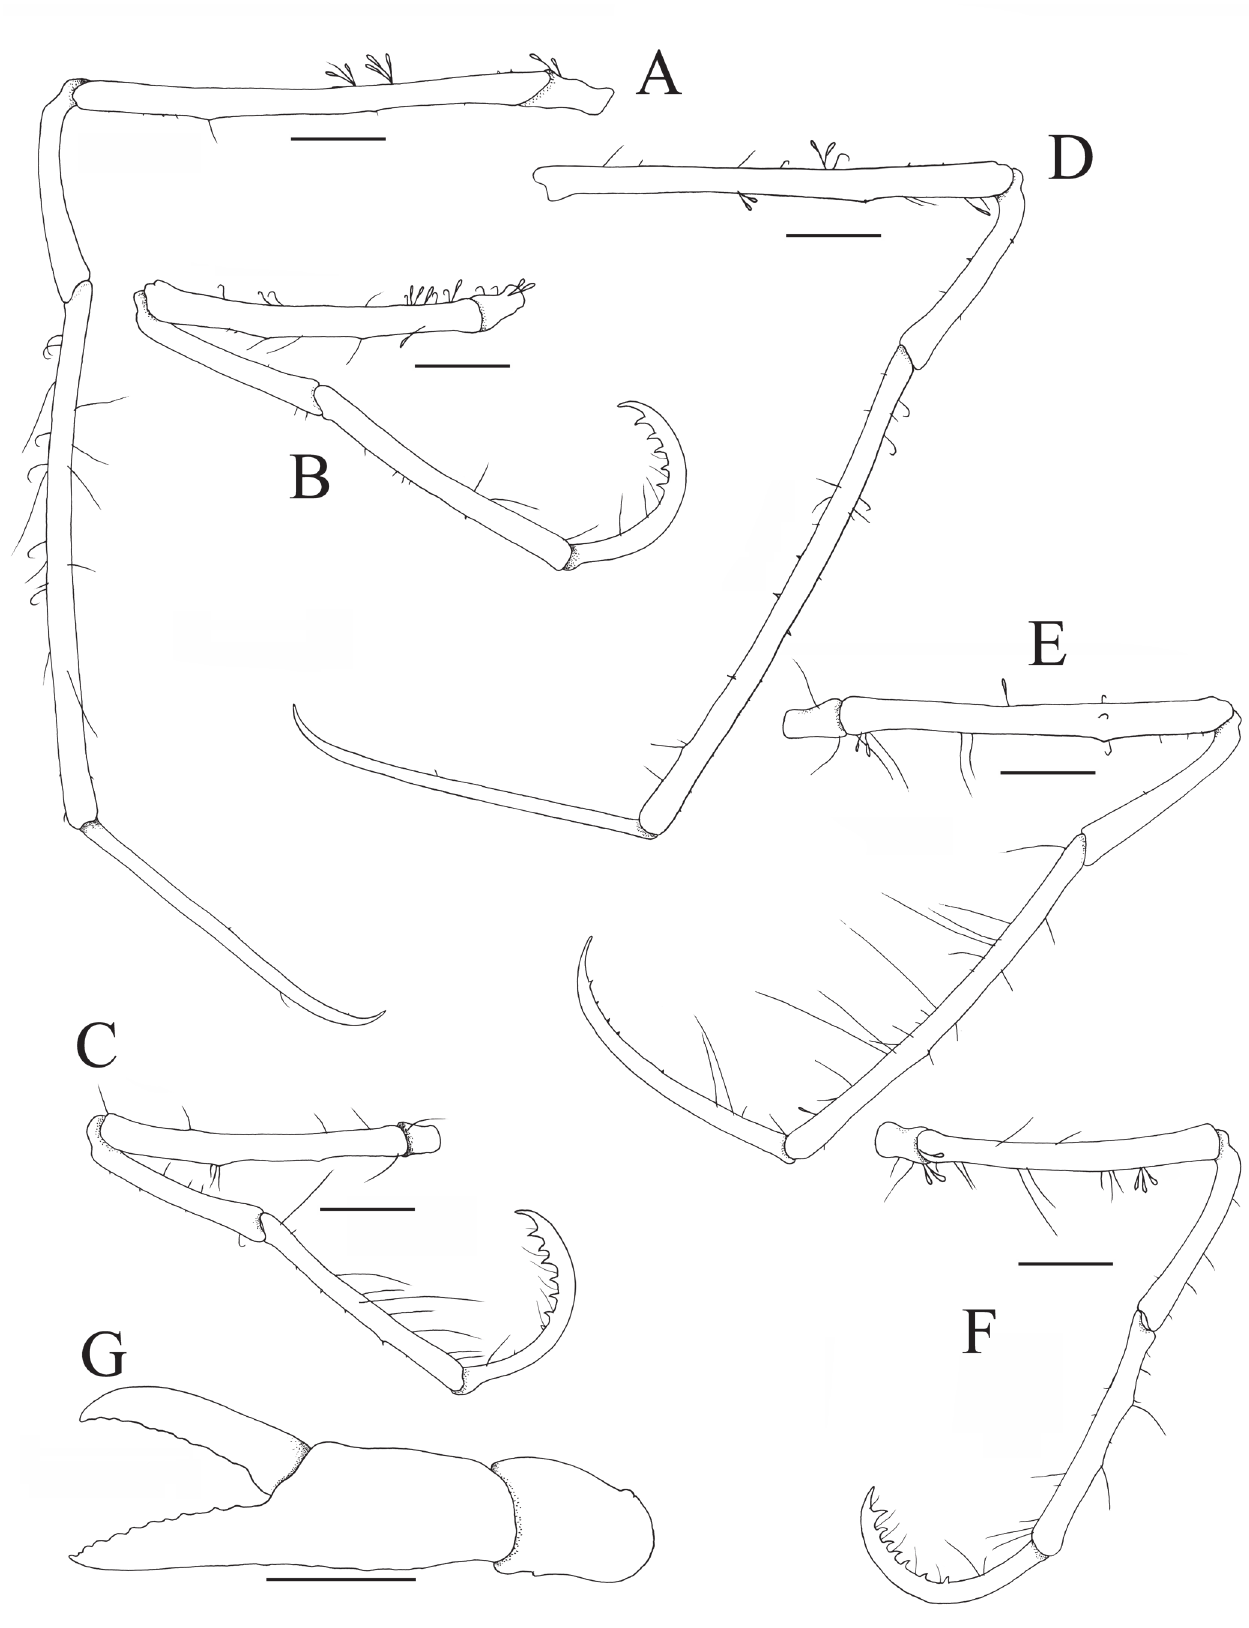
Figure 3. Achaeus umu n. sp., holotype female (1.9 × 2.7 mm) (USNM 1253231), Easter Island. A, left P2; B, left P4; C, left P5; D, right P2; E, right P3; F, right P5; G, outer view of left chela and carpus (denuded). Scales = 0.5